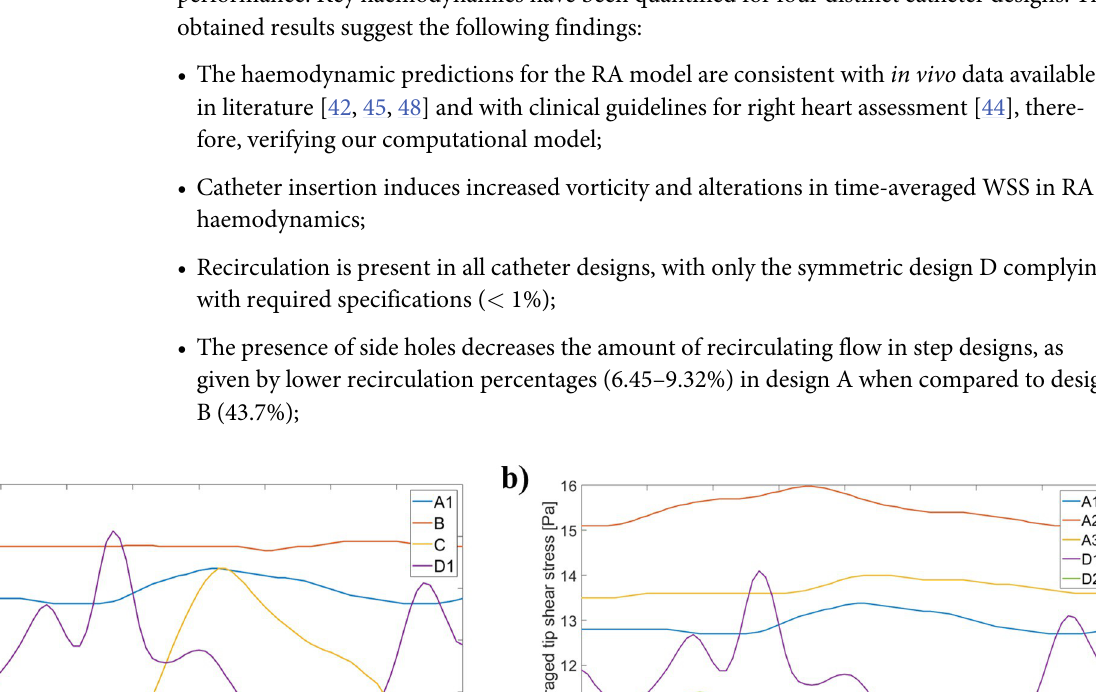
PLOS ONE | https://doi.org/10.1371/journal.pone.0247438 February 25,